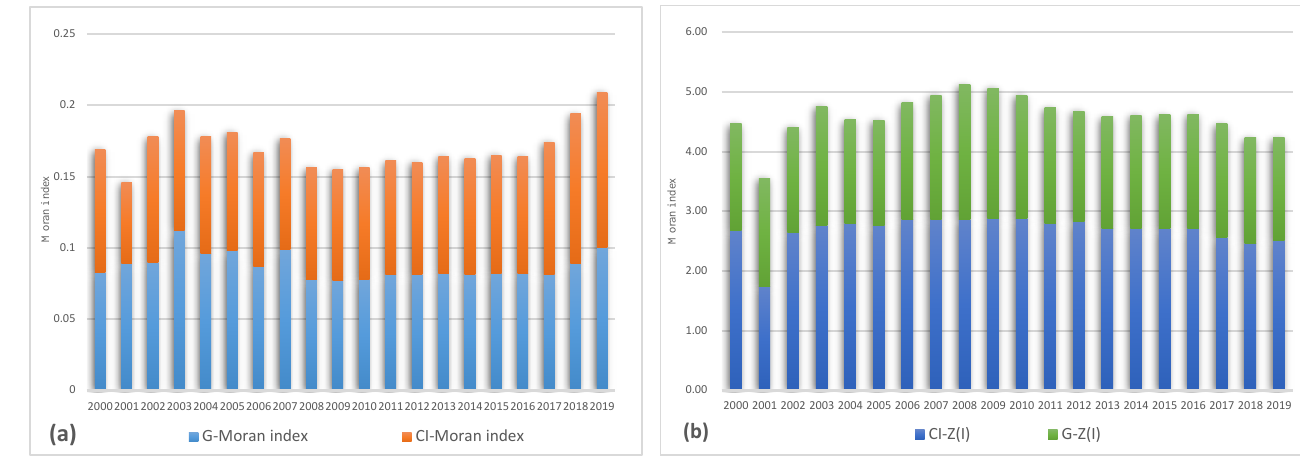
Figure 4. Variations in ( a ) Moran index, ( b ) Z value, the main expression is the relationship between total agricultural GHG emissions and GHG emissions intensity in The Main Stream of the Yellow River Basin in Gansu section from 2000 to 2019.